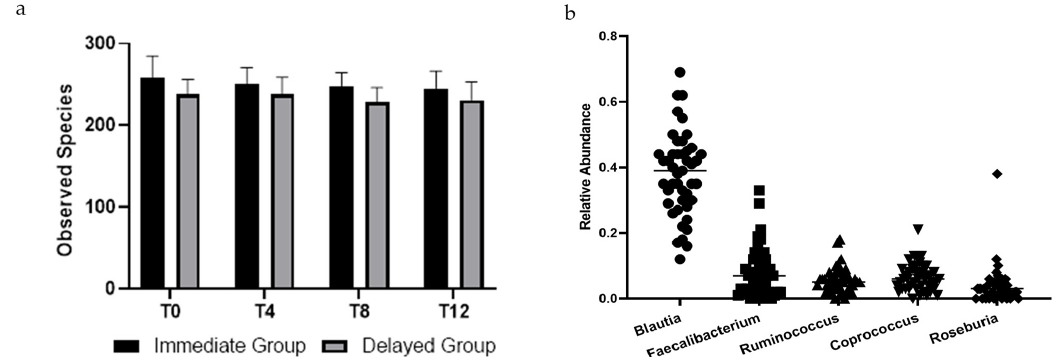
Figure 1. ( a ) Observed species of bacteria in stool samples collected from participants across all times points. There was no effect of time ( p = 0.391) or group × time ( p = 0.600). Points are means, and bars represent 95% confidence intervals. ( b ) Relative abundance of top five genera in stool samples collected at baseline of participants in a randomized controlled crossover high green leafy vegetable dietary intervention.